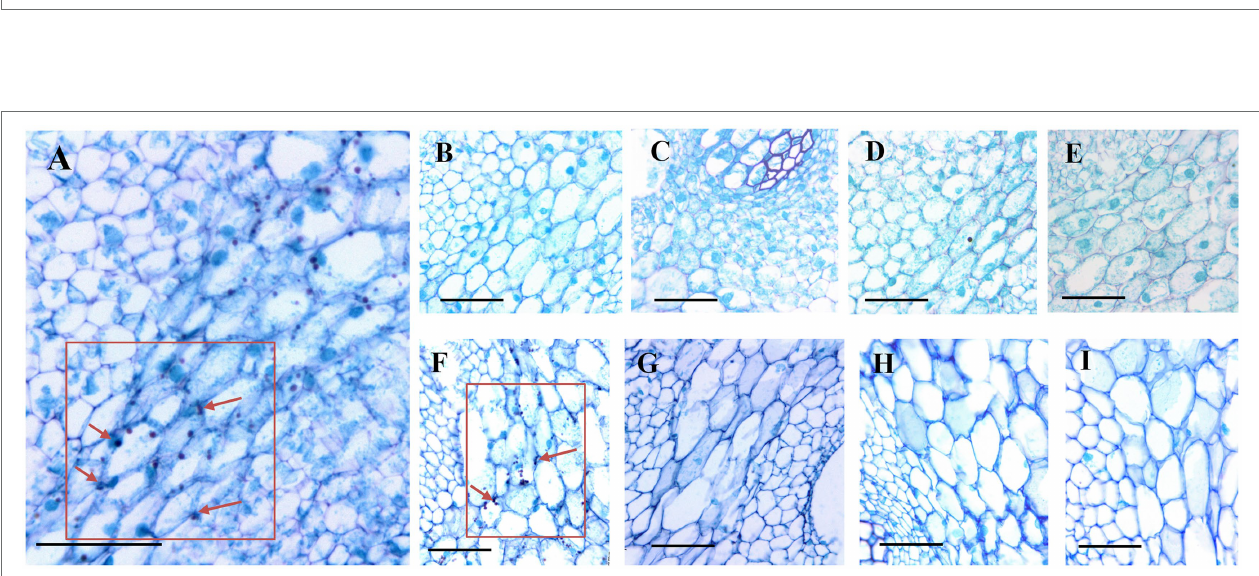
FIGURE 5 | Dynamics of starch grains in postharvest bamboo shoots during storage at 25 ° C and 4 ° C. Scale bar = 50 μ m. (A) Starch grains in the fresh-cut shoots. (B–E) Dynamics of starch grains in postharvest bamboo shoots during storage for 3 (B) , 6 (C) , 9 (D) , and 12 (E) d at 25 ° C. (F–I) Dynamics of starch grains in postharvest bamboo shoots during storage for 3 (F) , 6 (G) , 9 (H) , and 12 (I) d at 4 ° C. The arrow points to the starch